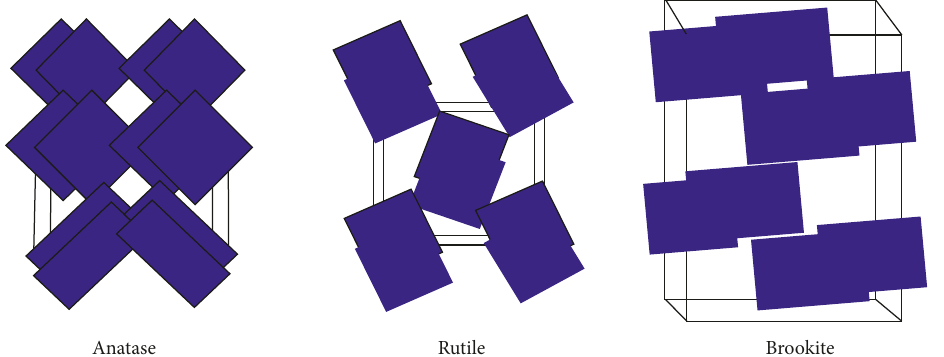
Figure 1: Crystal structure of nano-TiO